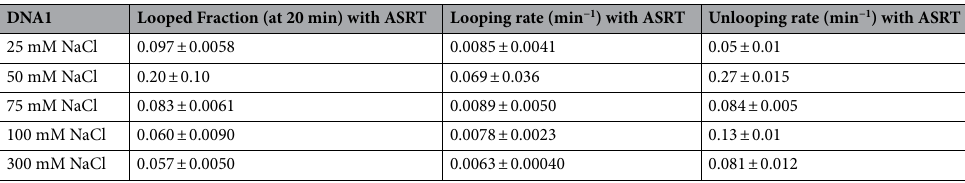
Table 2. Salt concentration dependent of DNA1-ASRT interaction.